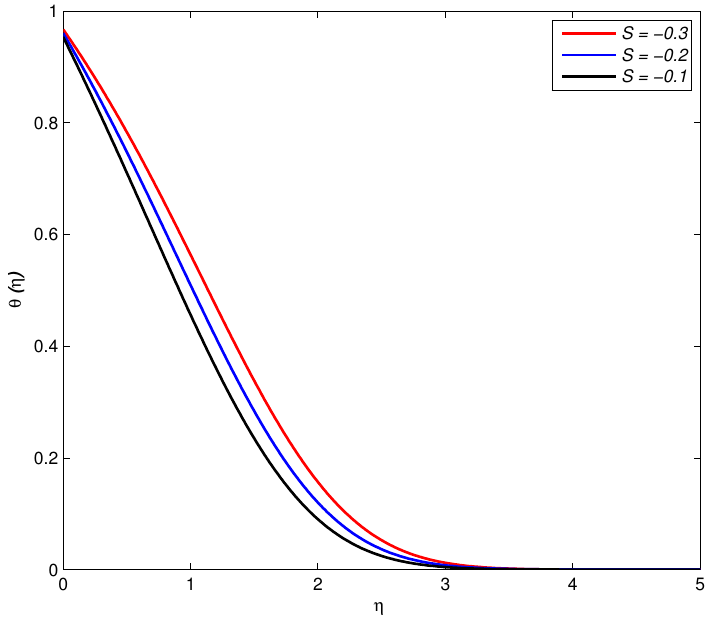
Figure 17. Temperature θ ( η ) profiles for different values of blowing parameter S <